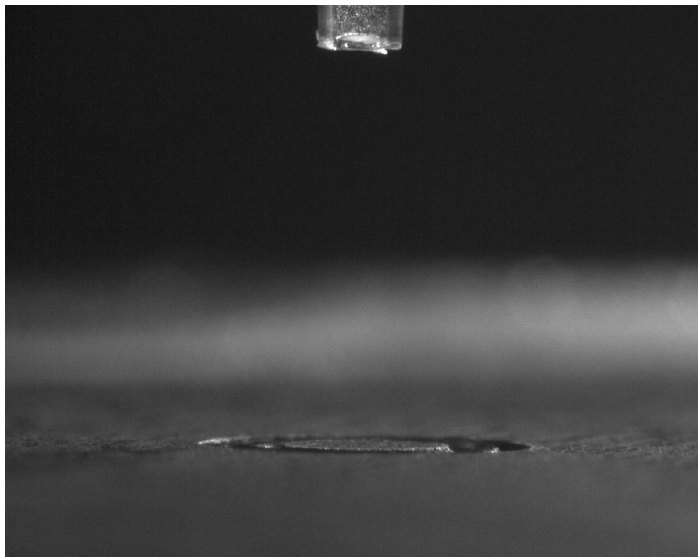
Figure 1. The groove with ice in it.